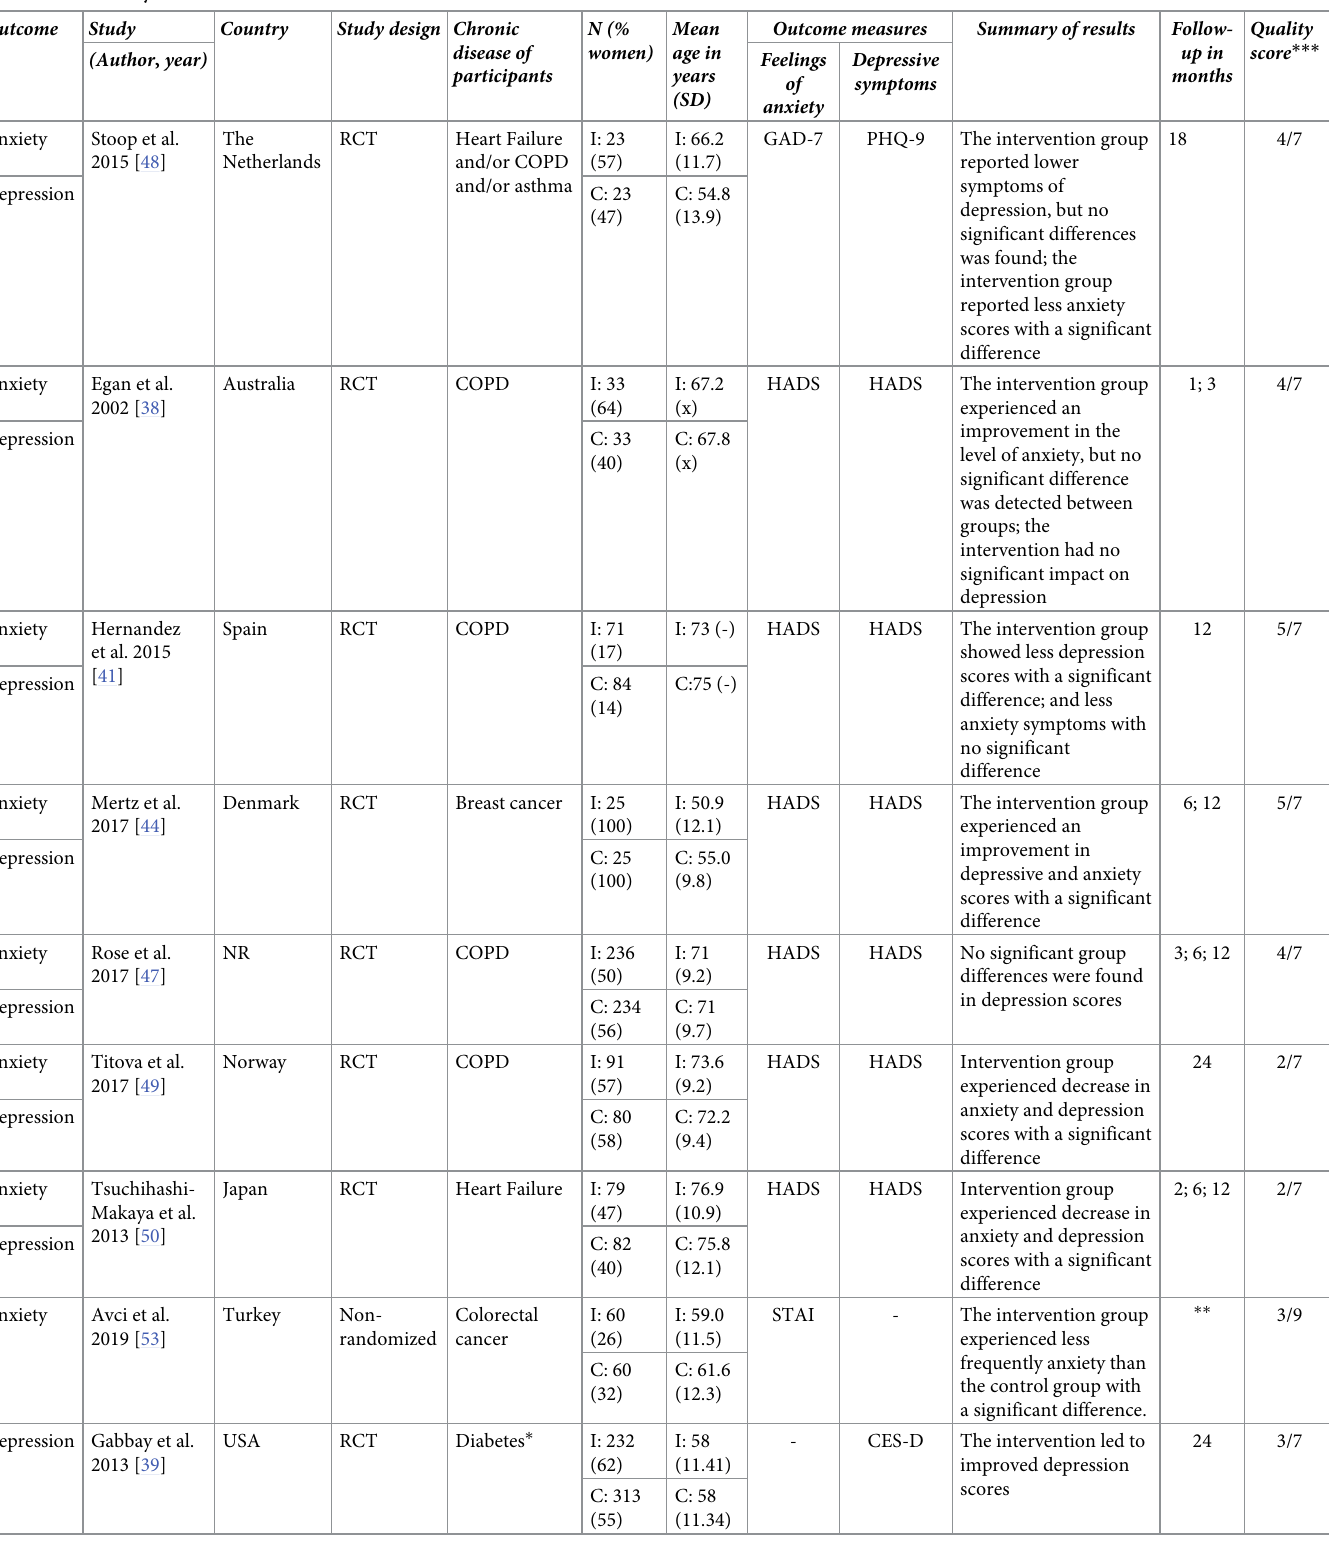
Table 2. Main study